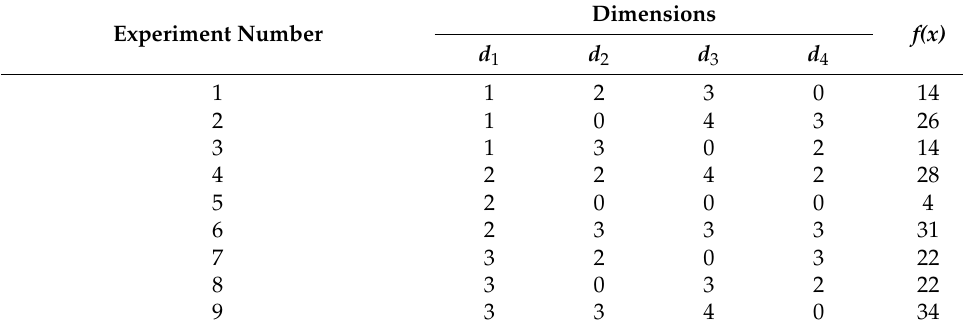
Table 2. The results of solution